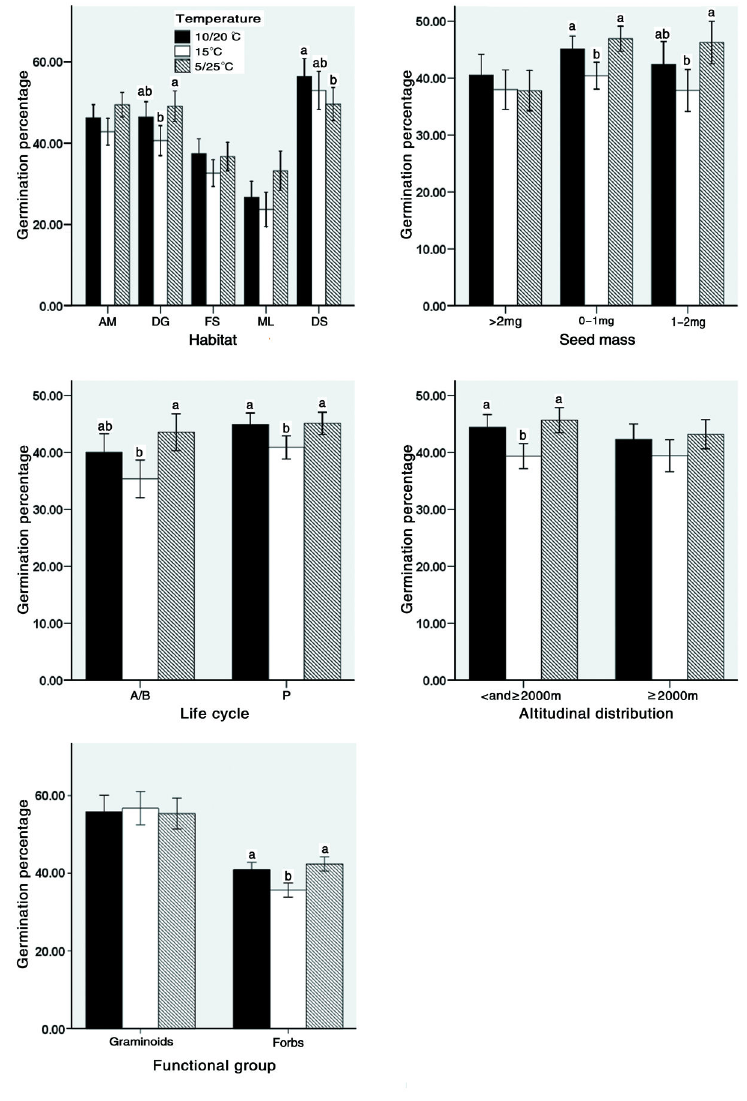
Figure 3. Germination percentages at different temperature regimes of species that differ in habitat, seed mass, life cycle type, altitudinal distribution and functional group. AM: alpine/ subalpine meadow; DG: disturbed ground; FS: forest margin/scrub; ML: marshland; DS: dry sunny slope; A/B: annuals/biennials; P: perennials; Error bars: ±SE. For each group of species, different letters on the bars indicate significant differences in germination under different temperature conditions at P < 0.05 (multiple comparisons with the Friedman Test).